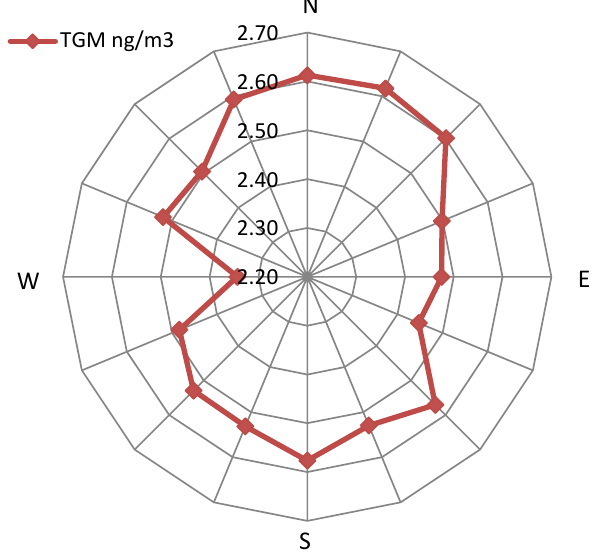
Figure 3. Concentration wind rose for SAWRS. TGM concentra- tion exhibited a strong dependence on wind direction. Higher TGM levels were frequently associated with northerly winds.